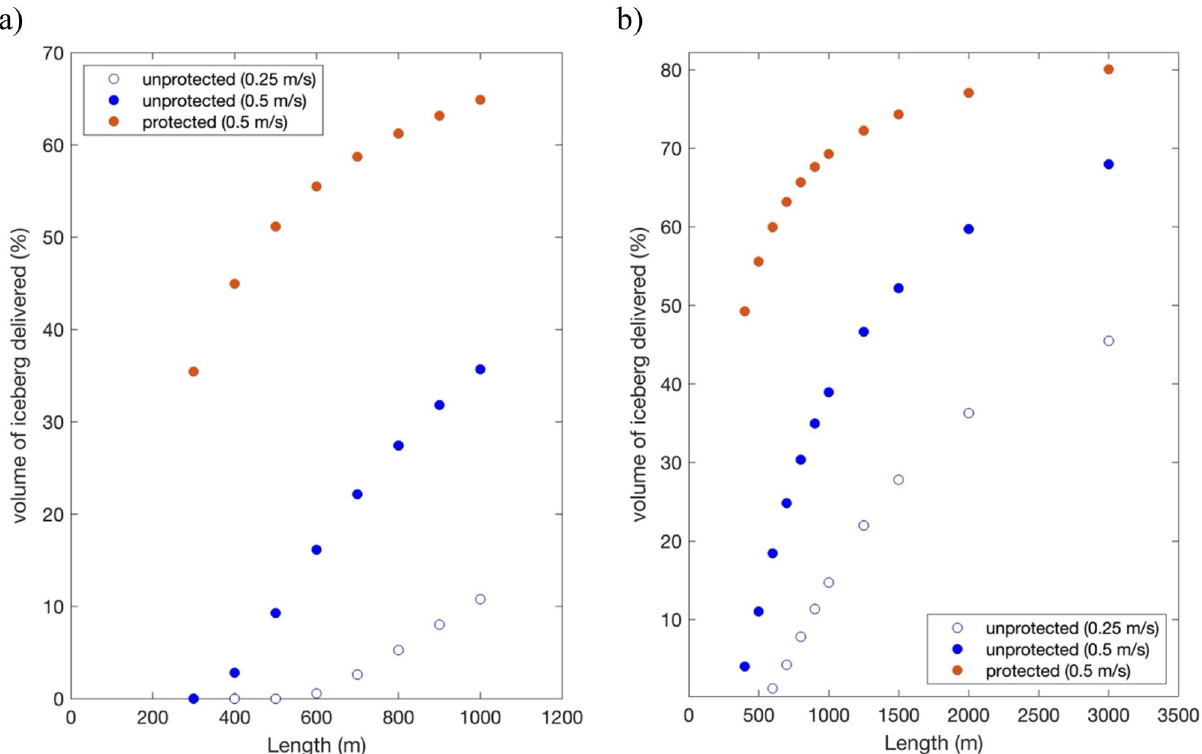
Figure 4. Percentage of deliverable ice to Cape Town, South Africa. Results are shown for 250 m thick ( a ) and 300 m thick ( b ) icebergs towed at 0.25 m/s and 0.5 m/s. Protected refers to experiments without wave-induced